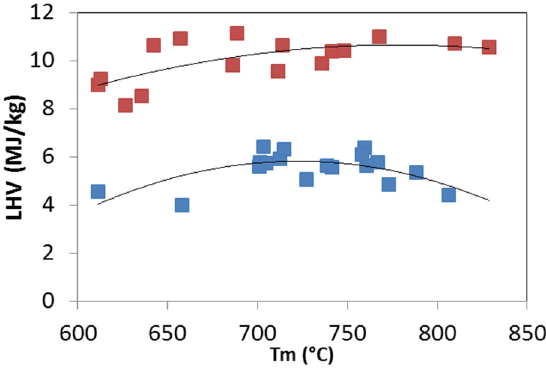
Figure 8. Low heating value of the syngas as function of the average temperature in the bed. Red symbols correspond to the experimental data of the oxy-gasification; blue symbols data of the air- gasification.